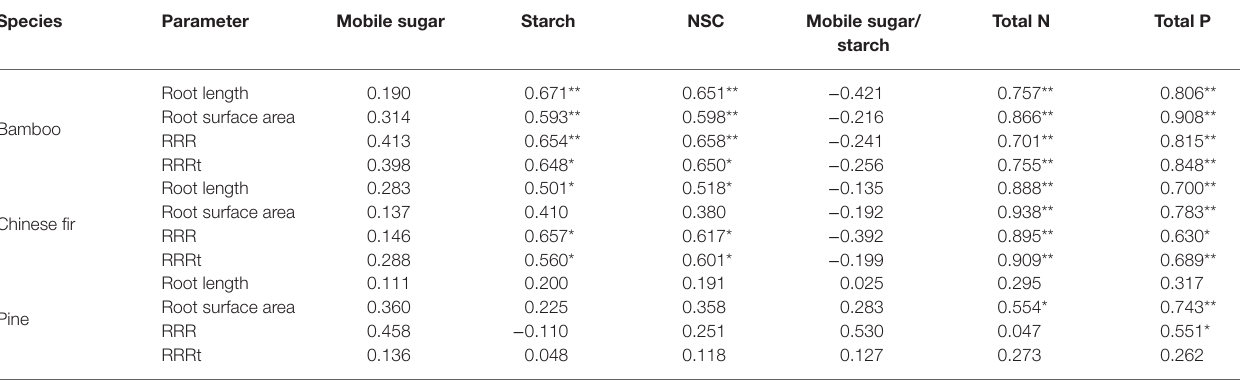
TABLE 3 | Analysis of Pearson correlations for the localized nutrient treatments. Species